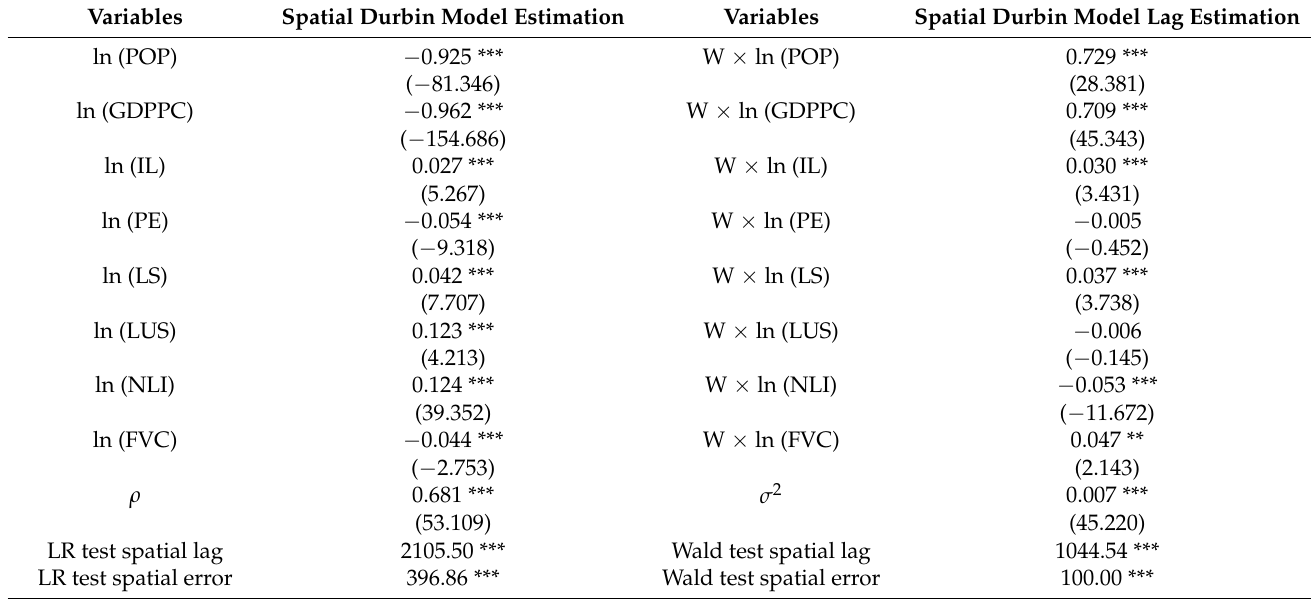
Table 4. Spatial Durbin model estimation